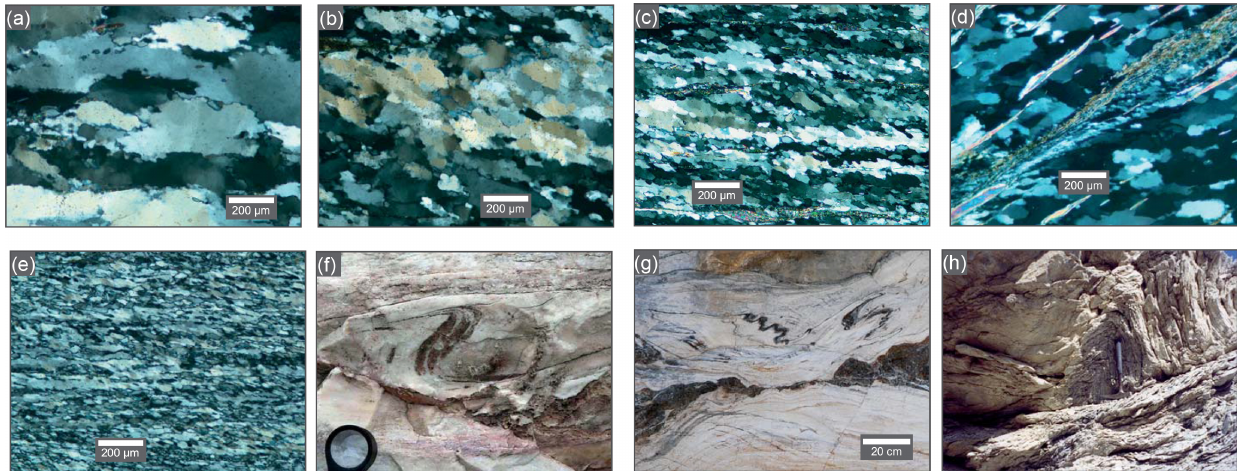
Figure 6. Field and thin section photographs from the northern Snake Range. Locations are shown in Fig. 2b and listed in Table 1. All thin sections are oriented with ESE to the left. (a) Coarse grained, high-temperature, low-strain microstructure in a non-mylonitic quartzite from immediately below the detachment on the western side of the range that has undergone a limited amount of high-stress, lower-temperature deformation producing grain-boundary bulging and dynamic recrystallization. The early microstructure is likely relict from the Cretaceous stage of prograde metamorphism, after which the rock was affected by high-stress deformation related to the NSRD. (b) A composite microstructure in the center of the range in which the large relict grains seen in (a) have been deformed and partly recrystallized under inter- mediate stress conditions close to the LDT. (c) A high-temperature, sub-LDT quartzite showing very high strain and a strong crystallographic preferred orientation. Through most of the section, oblique new grain-shape fabrics define a top-E sense of shear. Dynamic recrystallization occurs dominantly by subgrain rotation, producing grain sizes from ∼ 20 to 50µm. (d) Mylonitic quartzite located ∼ 20m below the NSRD on the eastern side of the range showing a sub-LDT high-temperature, high-strain, low-stress (Regime 3) microstructure (grain size ∼ 60µm) overprinted by narrow high-stress micro-shear zones lying parallel to the main foliation (grain size ∼ 5µm). We interpret this localized ductile overprint as detachment-related deformation above the LDT. Therefore, this sample captures the transition through the LDT from distributed to localized deformation. (e) Superimposition of a high-stress, detachment-related microstructure on an intermediate-stress sub- LDT microstructure less than ∼ 20m beneath the detachment. The resulting composite microstructure displays Regime 2 deformation with relict 50µm size grains overprinted by dynamic recrystallization to a grain size of ∼ 15µm. (f) Attenuated fold in sub-detachment Marble Wash calc-mylonites, with a geometry comparable to the winged inclusions found in ultramylonites of the Ruby Mountains–East Humboldt Range footwall (Fig. 7e; view to NE). (g) Brittle–ductile deformation in calcareous units directly beneath the NSRD formed during transition through the BDT from ductile to brittle conditions during cooling and exhumation (view to W). (h) Folded and disrupted gouge zone along the NSRD, representing the final step in the exhumation path (view to